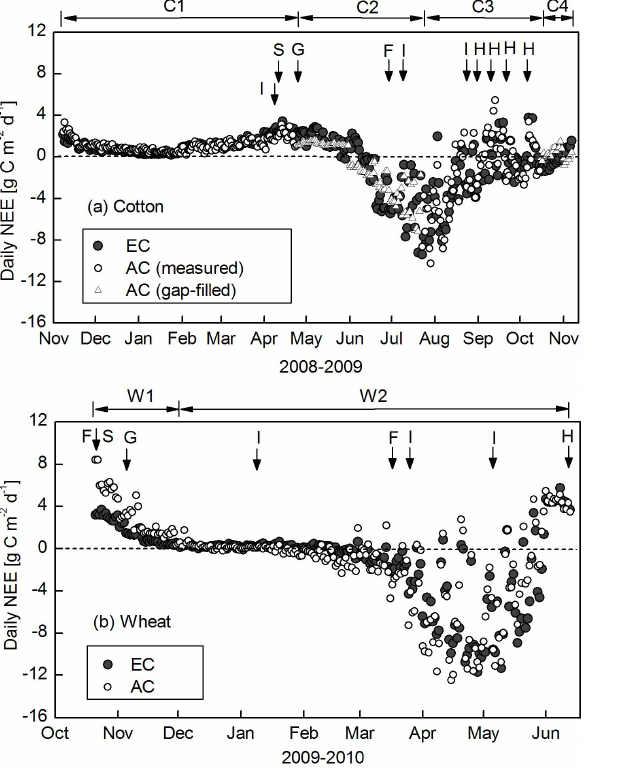
Fig. 5. Daily NEE fluxes measured using the eddy covariance (EC) and automatic static chamber (AC) techniques in the (a) cotton and (b) wheat